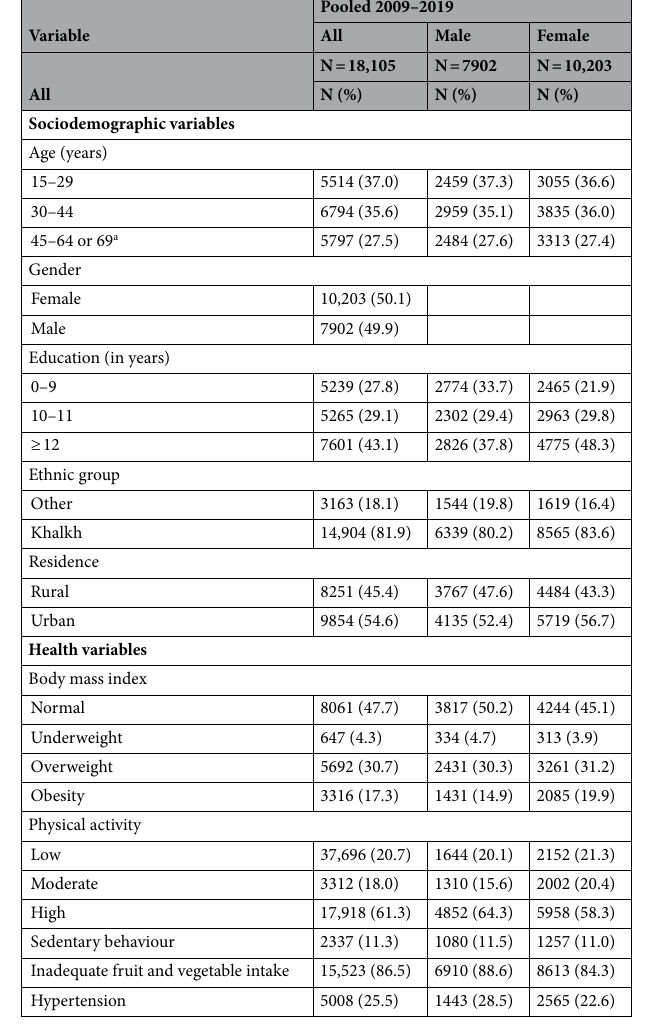
Table 2. Sample characteristics, 15 years and older individuals, Mongolia 2009–2019. a 15-64 years in 2009 and 2013, and 15–69 years in